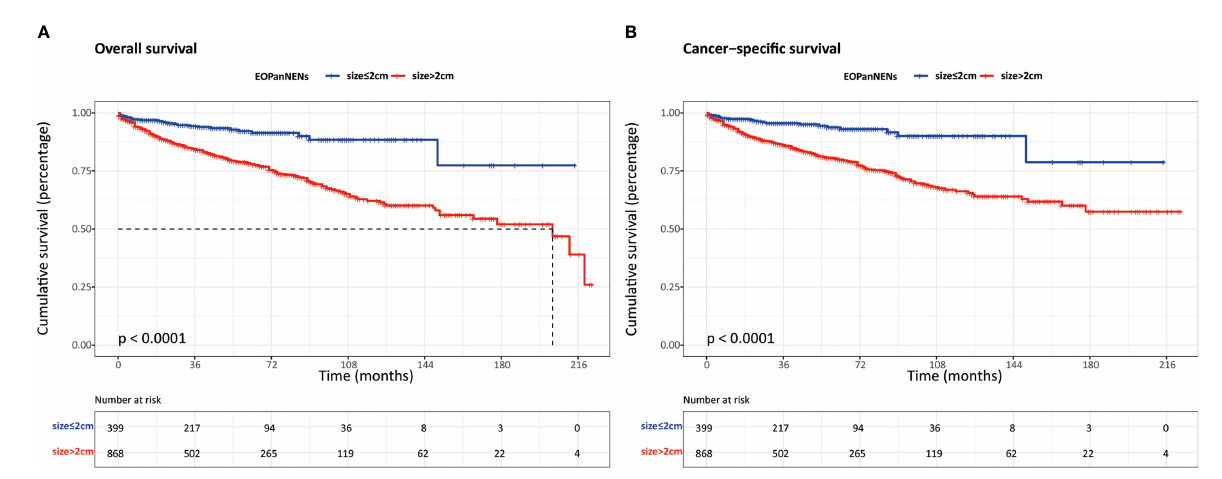
FIGURE 9 The overall survival (A) and cancer-speci fi c survival (B) between EOPanNENs ≤ 2cm and EOPanNENs